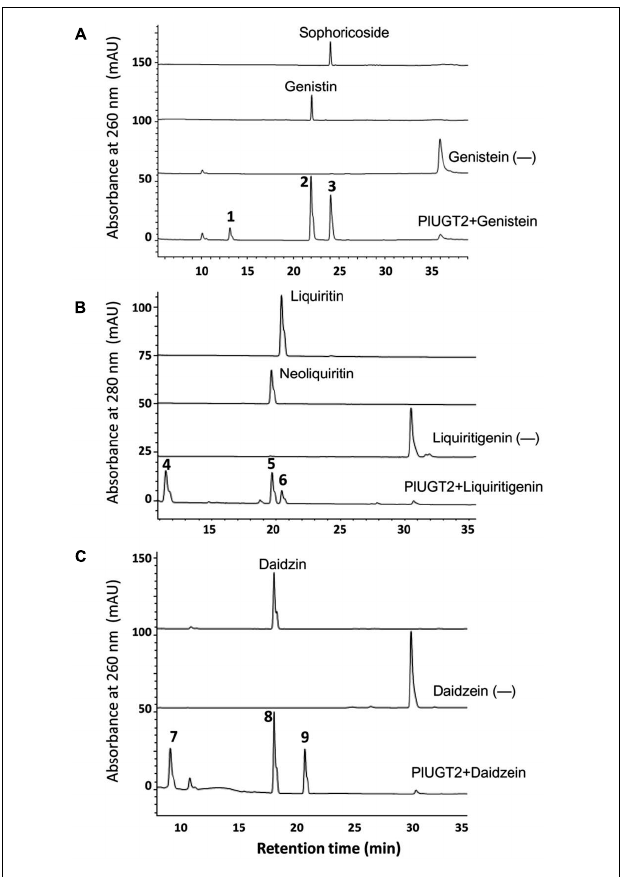
FIGURE 4 | High-performance liquid chromatography (HPLC) analysis of the products from the in vitro reactions of the recombinant PlUGT2 with genitein (A), liquiritigenin (B), and daidzein (C). PlUGT2 was able to converted these (iso)flavone aglycones to yield their respective 4 (cid:48) ,7- O- diglucosides (peaks 1, 4, 7), 7- O- mono-glucosides (peaks 2, 5, 8), and 4 (cid:48) - O- mono-glucosides (peaks 3, 6, 9). ( − ) Indicates control reactions without